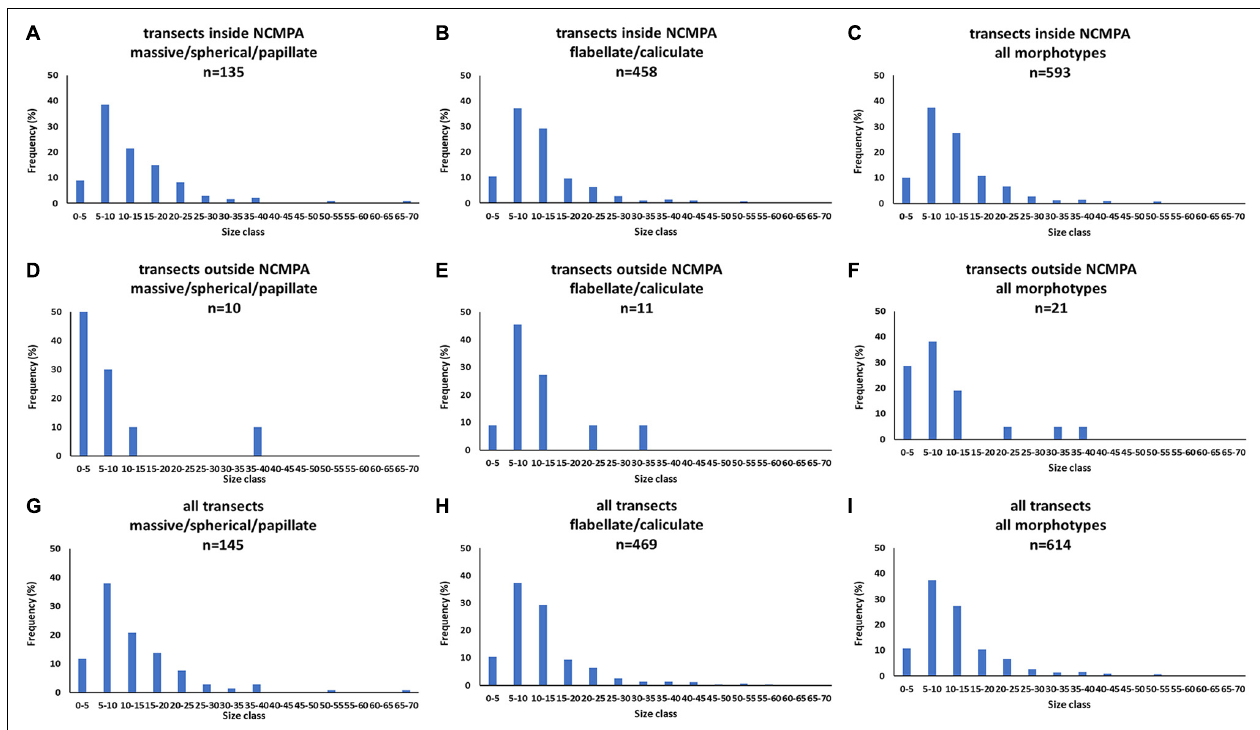
FIGURE 9 | Size-frequency distributions of sponge size (cm) for transects (i) inside the Faroe-Shetland Channel Nature Conservation Marine Protected Area (FSC NCMPA) (A–C) , (ii) outside the FSC NCMPA (D–F) , (iii) all transects (G–I) . Data are shown for Category 3 (massive/spherical/papillate), Category 4 (flabellate/caliculate), and for all sponge